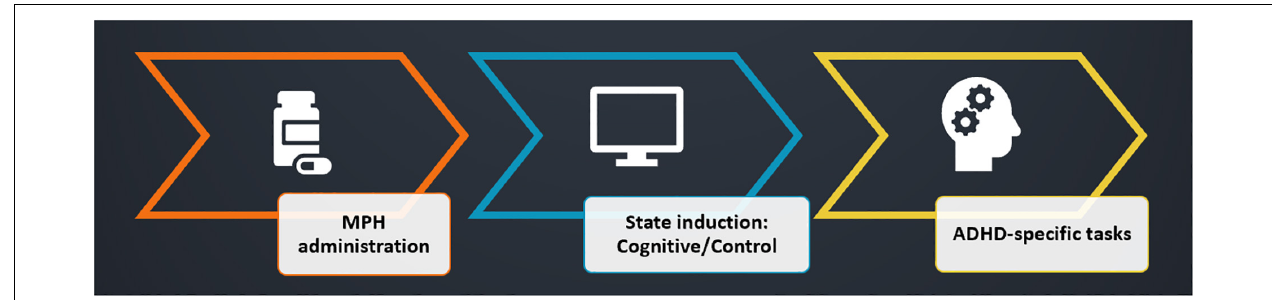
FIGURE 6 | Experimental design. Participants were administered with MPH, coupled with a cognitive/control state induction (session order was randomized). ADHD-specific tests were performed as a measure of the functional-pharmacological coupling effect. Both induction tasks started 15 min following drug administration, and duration was 1 h, followed by a short break. Measurement of the dependent variable (ADHD-specific attention tests) was performed 1.5 h post-MPH administration, at a time when peak MPH levels are expected in the brain.